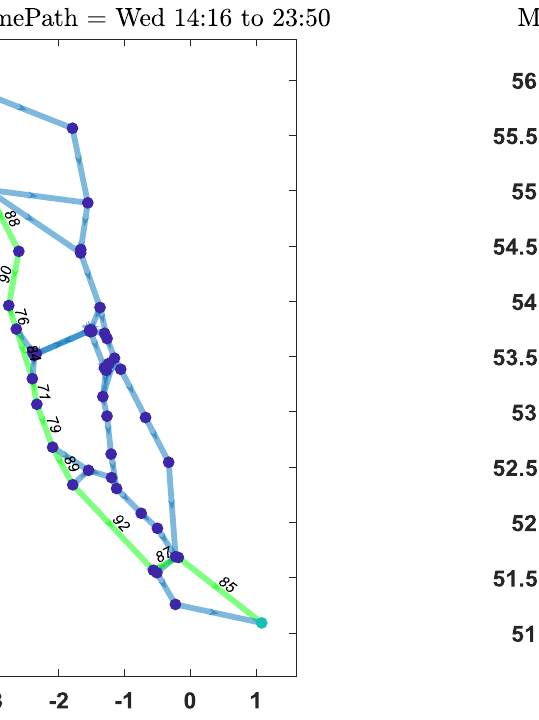
Figure 11. Optimal routes from Glasgow to Eurotunnel, (left) minimum travel time [574 mins, 378.4 litres] and (right) minimum fuel-consumption [812 mins, 325.6